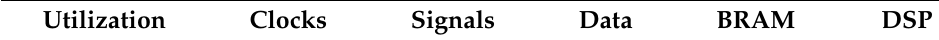
Table 6. The DPU dynamic power consumption on ZCU 104 in Watts.